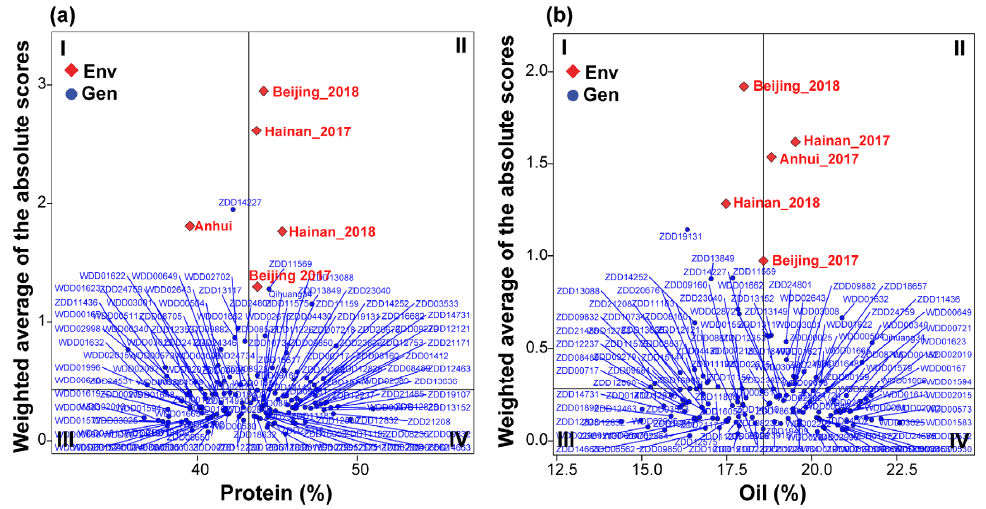
Figure 1. Biplot showing the performance vs. stability of 135 soybean genotypes for protein content ( a ) and oil content ( b ). The x-axis shows the arithmetic mean for each genotype × environment interaction. The y-axis shows the weighted average of absolute scores from the singular value decomposition of the matrix of best linear unbiased predictions for the genotype × environment interaction effects.